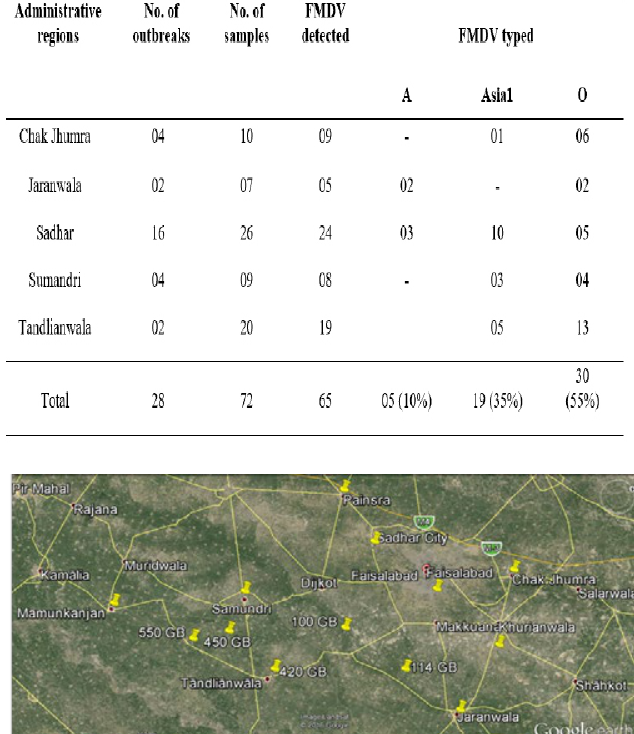
Table 2. FMDV outbreak locations and results of Faisalabad district